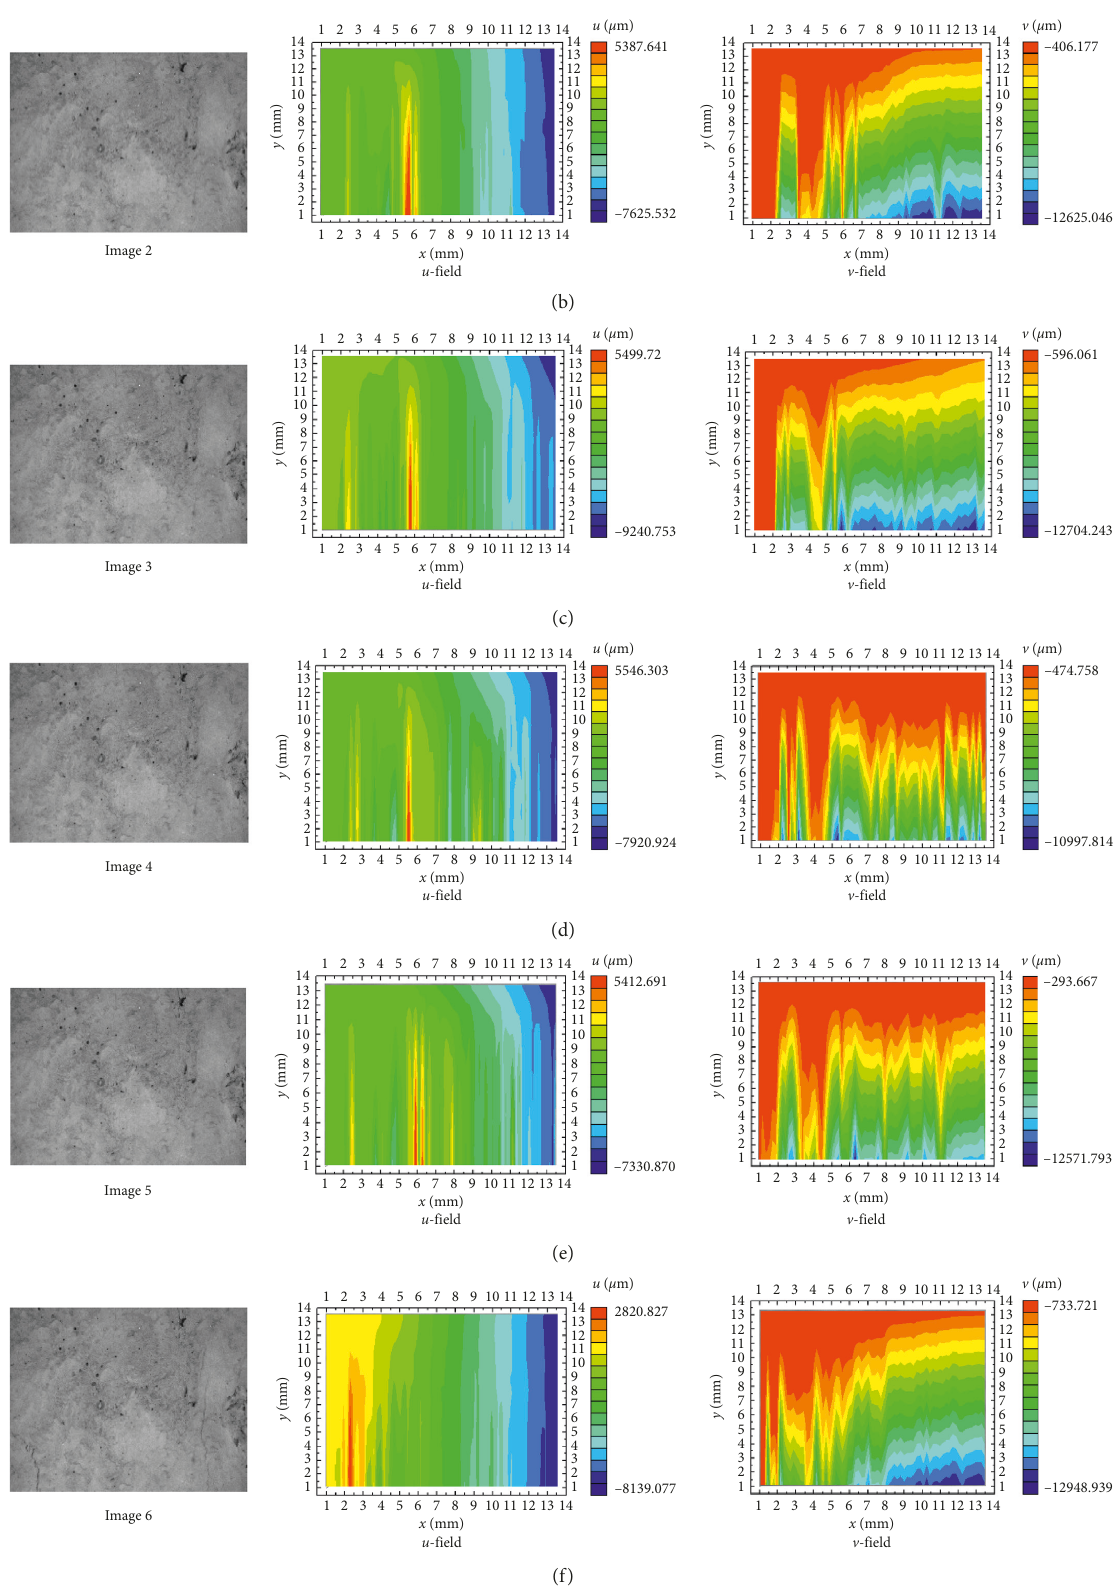
Figure 12: The field displacement ( u, v ) of the first crack area and surface topographies on the RM-YPS-CC surface at the age of 28 days under (a) 5MPa; (b) 10MPa; (c) 15 MPa; (d) 20 MPa; (e) 25MPa; and (f)